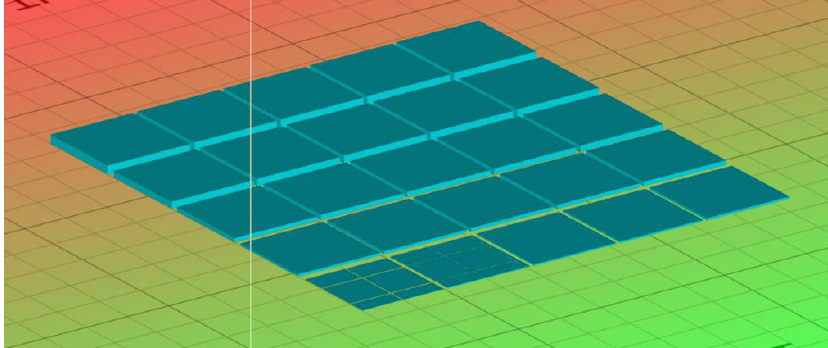
Figure 1. The 3D model used to determine the resin curing characteristics. The part had 25 layers in total, with the height of each layer being 0.05 mm. Each square was exposed to light in an arithmetic progression increasing from 1 to 25. Furthermore, to avoid the effect of light scattering, the squares were separated by a gap of 1 mm. The height of each tile was measured three times using a digital caliper with 0.01 mm of resolution (Preciva Digital Caliper) and a ±10% deviation was assumed [46]. Finally, with the height of each tile, the maximum exposure of a tile was calculated using Equation (5).